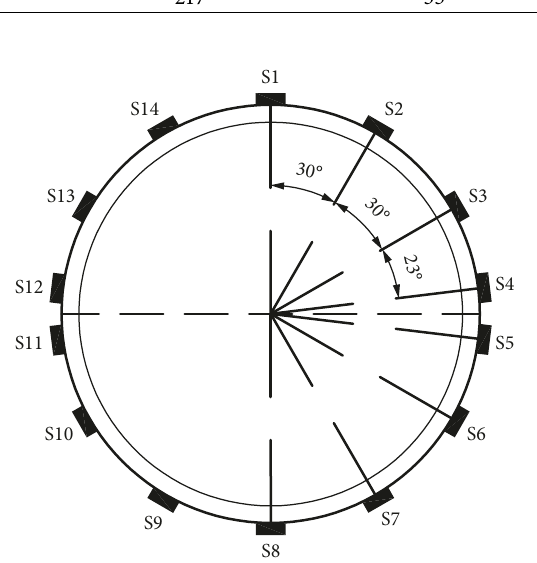
Figure 7: Strain sensors